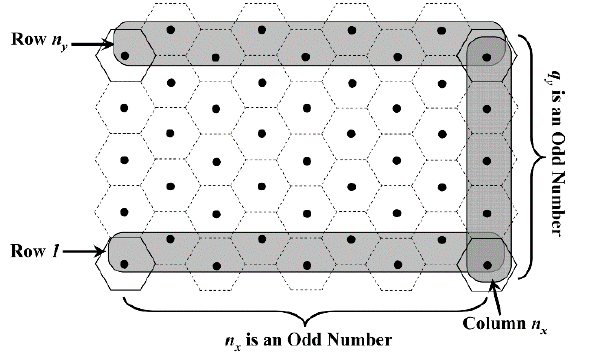
Figure 9. Distribution of VTPs when both q y and n x are even numbers.